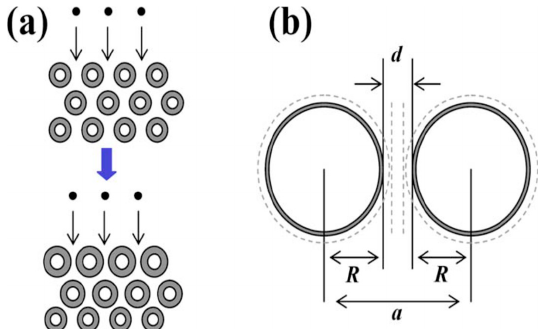
Figure 1. ( a ) Swelling of single-walled carbon nanotube (SWCNT) bundles during hydrogenation. ( b ) Characteristic dimensions of the bundle, namely, SWCNT radius, R, SWCNT center-to-center distance, a, and the intertube spacing, d. The dashed lines are used to indicate deformation due to SWCNT swelling upon hydrogenation [89] .